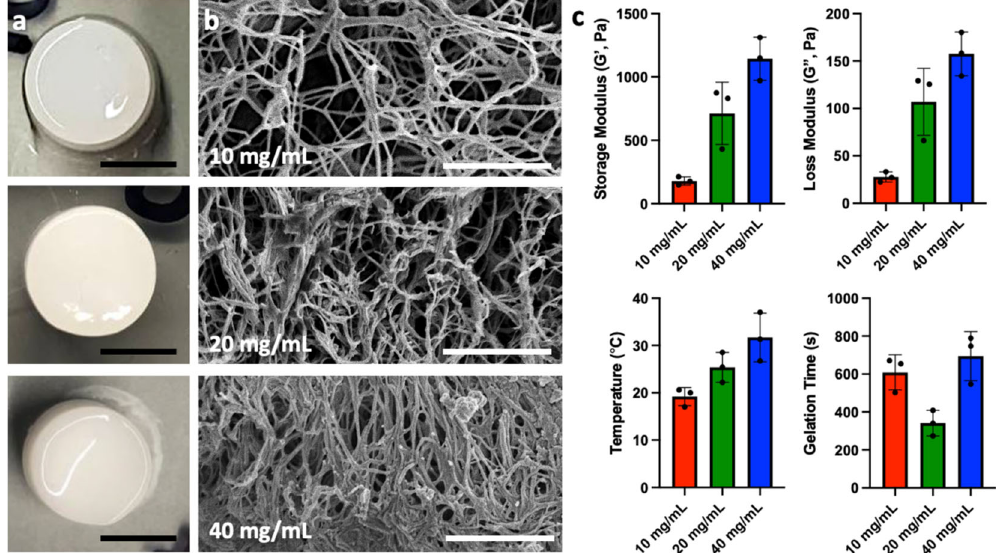
Fig. 3 Characterization of decellularized nerve tissue-speci fi c hydrogel. Macroscopically, hydrogels were formed at all protein concentrations, but the ability of the material to retain fl uid was observed to increase at higher concentrations ( a ). Scale bars 0.5 cm SEM imaging was used to examine the microstructure of gels resulting from protein concentrations of 10 mg/mL, 20 mg/mL and 40 mg/mL ( b ). Increasing fi ber density was observed with increased protein concentration. Scale bars 2.5 μ m. Representative curves from rheologic testing, varying protein concentration ( c ) are shown. Storage modulus, loss modulus, gelation temperature, and gelation time are shown ( c ). Data are presented as mean ±